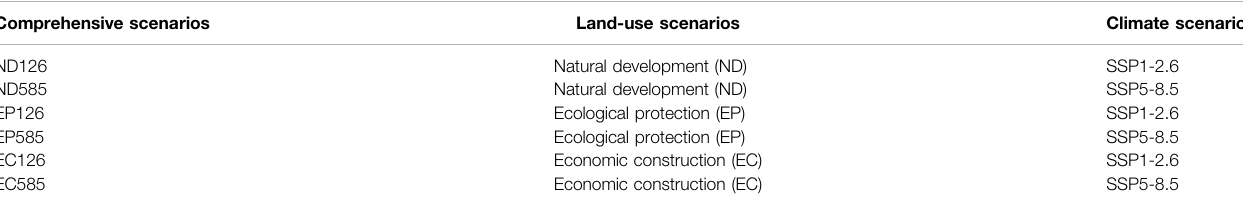
TABLE 3 | Land-use and climate scenario